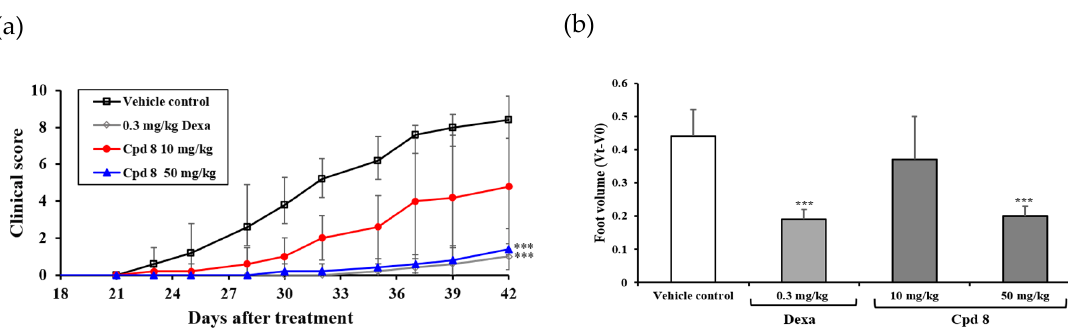
Figure 6. Efficacy of compound 8 in a murine model of collagen-induced arthritis (CIA). ( a ) Mean clinical scores following daily oral treatment with compound 8 , on days 21–25, 28–32, and 35–39, with different doses of compound 8 and dexamethasone are represented as the mean ± SD ( n = 5). Mice with CIA in the control group received the vehicle only. Clinical scores following treatment with 0.3 mg/kg dexamethasone or 10 and 50 mg/kg of compound 8 differed significantly from those with the control. * p < 0.05, ** p < 0.01, and *** p < 0.001 indicate a significant difference, according to the t -test.